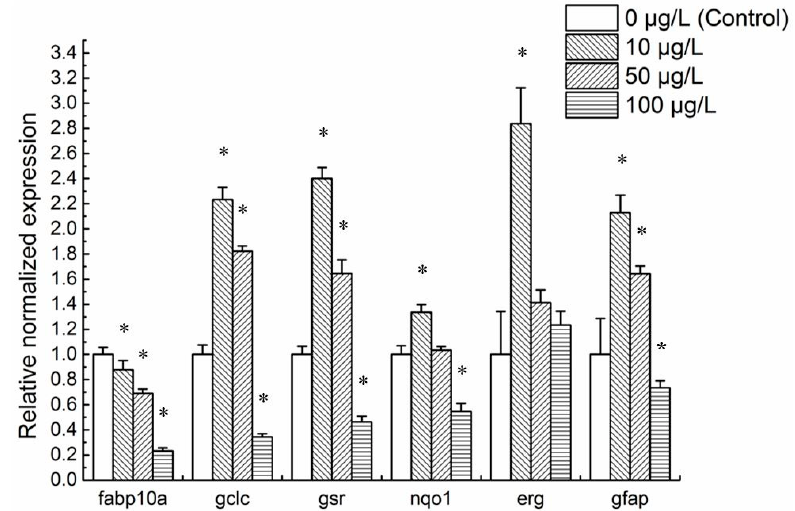
Figure 3. The expression analysis of classical toxicity biomarker genes in 48 hpf embryonic zebrafish exposed to mitoxantrone. Each group is conducted in triplicate ( n = 3). All values are expressed as means ± standard error of the mean (SEM). * represents significant difference compared to the corresponding control (0 μ g/L mitoxantrone) groups, p < 0.05.